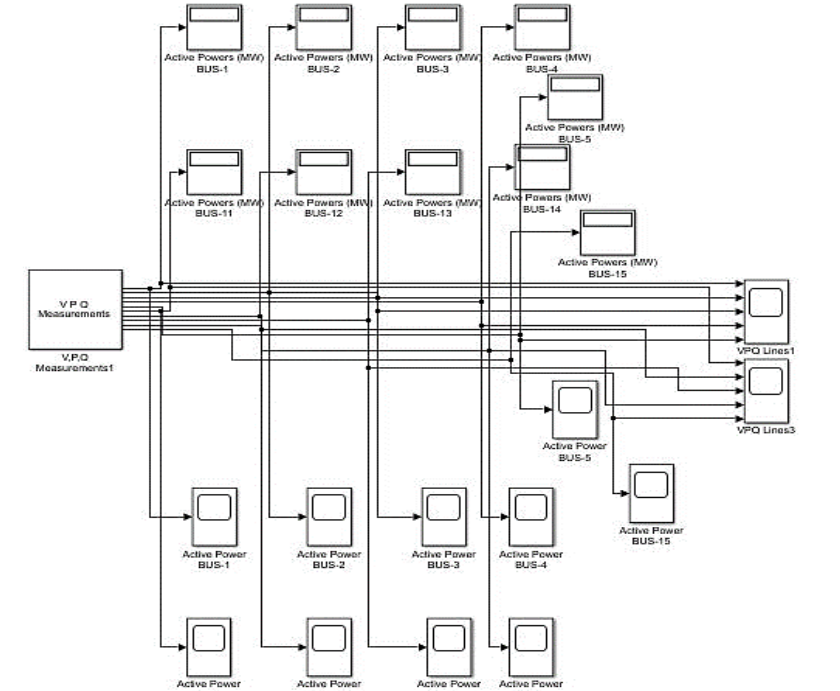
Figure 11. VPQ measurement block subsystem.